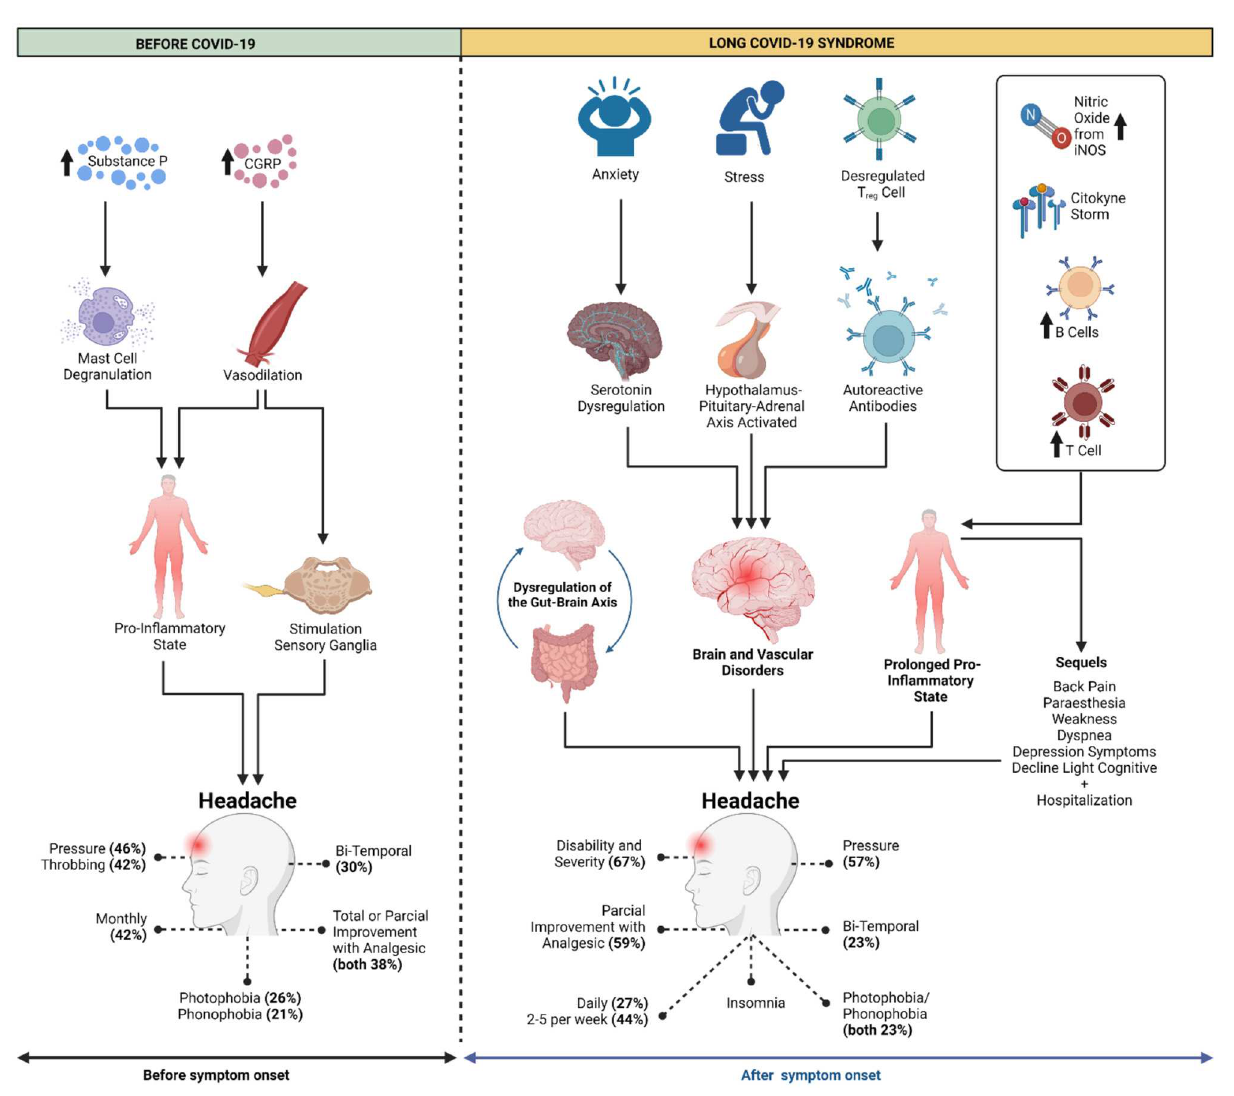
FIGURE3 Headache prior to COVID-19 is explained by the release of substance P and calcitonin gene related peptide (CGRP) to induce mast cell degranulation and vasodilation, respectively, leading to a proinflammatory state that, when associated with stimulation of sensory ganglia, trigger headache. In long COVID-19 syndrome, stressors and anxiety could lead to changes in neurotransmitters and neurohormonal pathways, triggering brain and vascular changes. In addition, fragments of remaining pathogens may induce the creation of autoantibodies and increase the release of inflammatory cells, such as cytokines and B and T cells, which are associated with the increased production of nitric oxide by inducible nitric oxide synthetase (iNOS). This could lead to a prolonged proinflammatory state, eventually leading to the main post-COVID-19 sequelae. Moreover, disorders of the gut flora can alter the gut-brain axis. All of these factors could contribute to new cases of post-COVID-19 headache and/or worsening of pain in patients with previous headache. Created with BioRender.